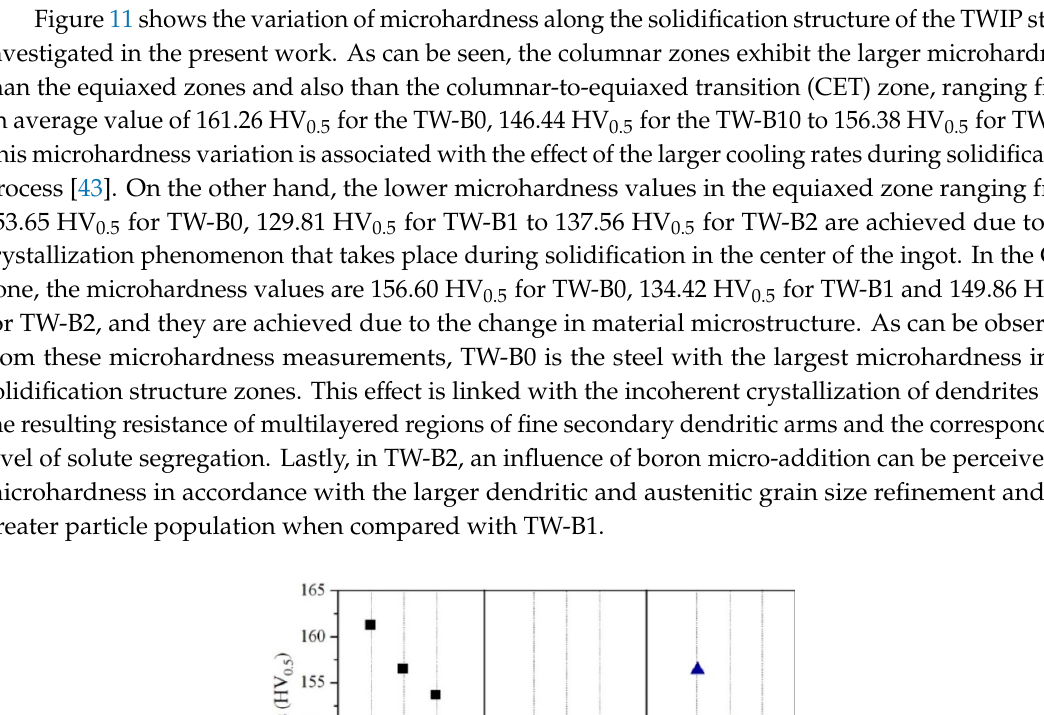
Table 3. Obtained magnetic properties in studied TWIP steels.